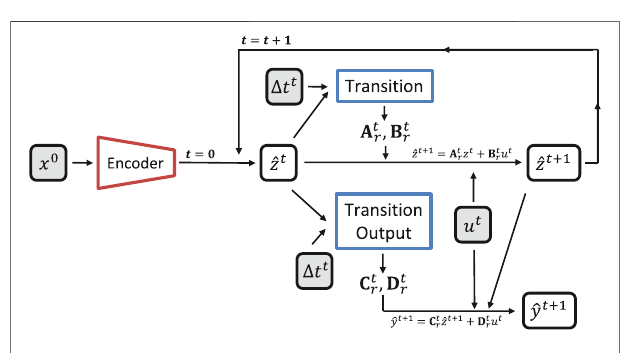
FIGURE 7 | E2CO prediction diagram (proposition